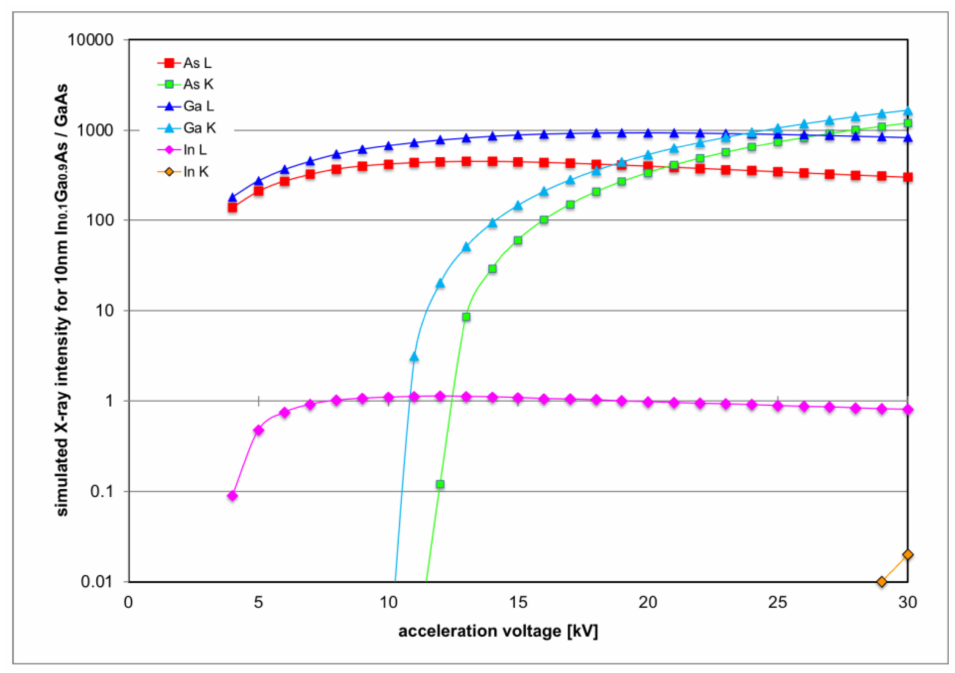
Figure 3. Monte Carlo simulation of the intensities of various X-ray lines for 10 nm In 0.1 Ga 0.9 As/GaAs as function of electron acceleration voltage.